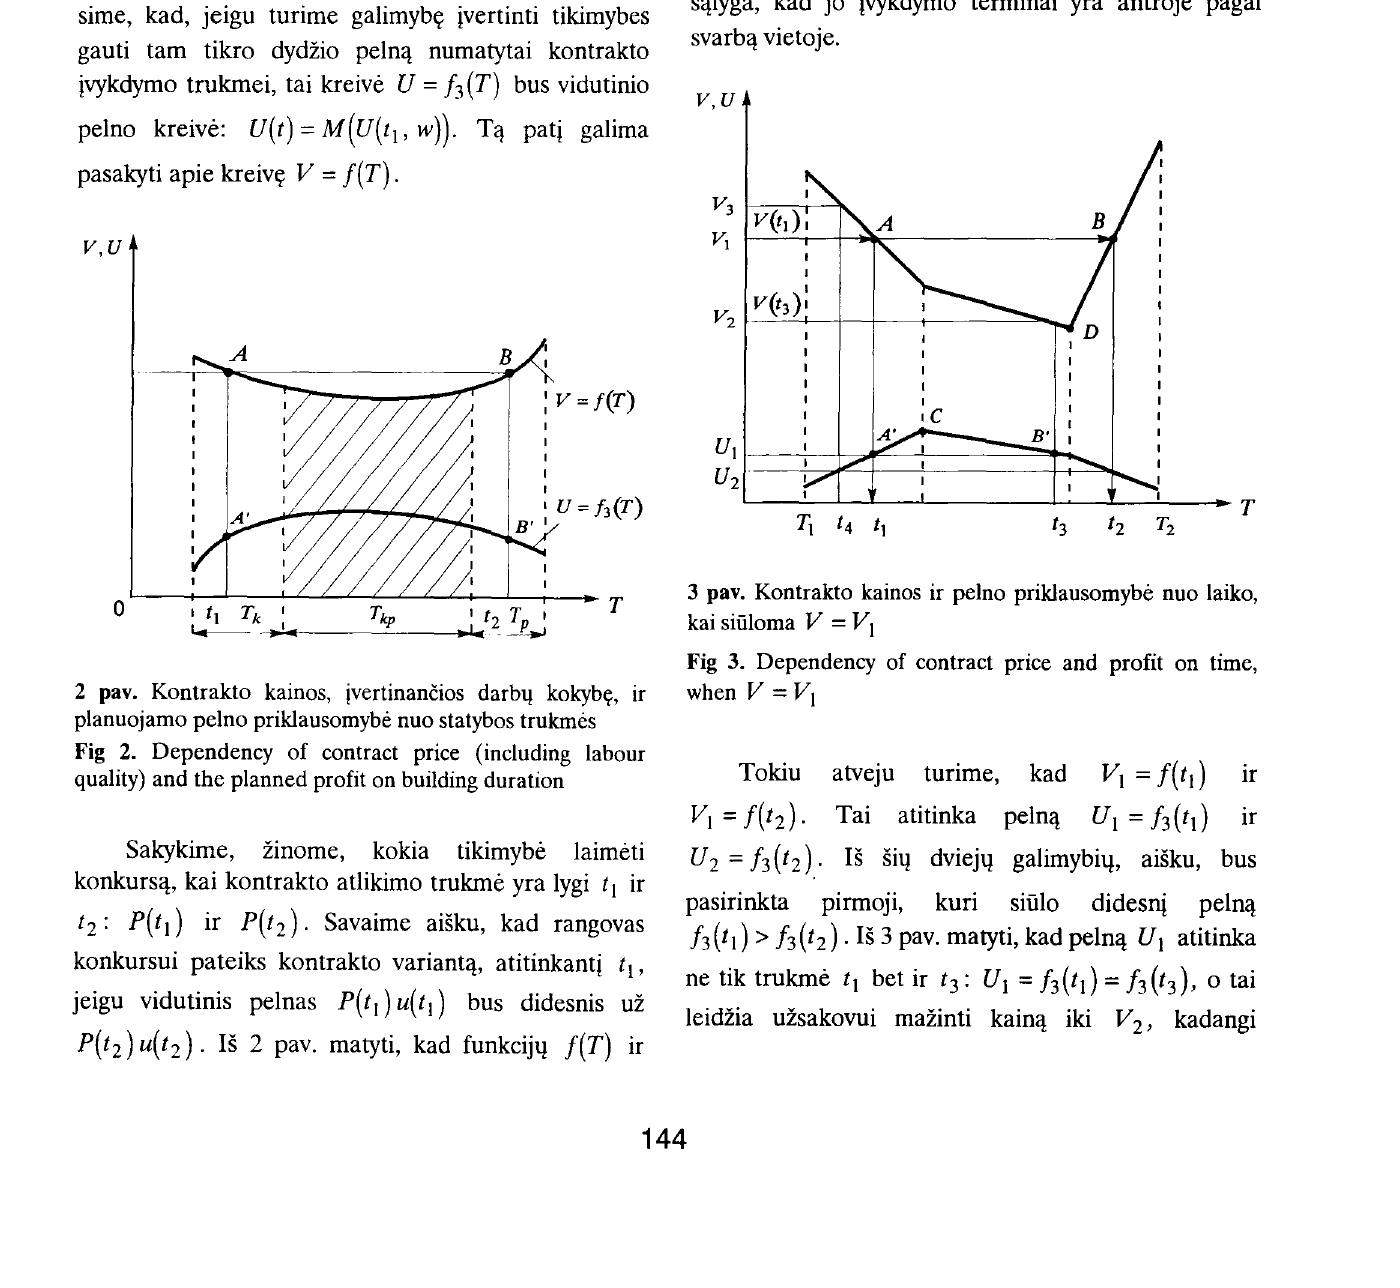
Fig 2. Dependency of contract price (including labour quality) and the planned profit on building duration Sakykime, t 2 : P(tJ) ir P(t 2 ). Savaime aisku, kad rangovas konkursui pateiks kontrakto variantq, atitinkantj t jeigu vidutinis pelnas P(tJ) u(ti) bus didesnis uz P(t u(t 2 ) 2 ). IS 2 pav. matyti, kad funkcijq